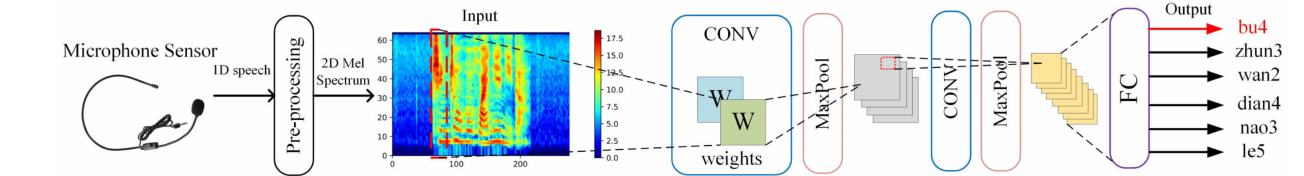
Figure 1. A typical Chinese speech recognition convolutional neural network where [bu4, zhun3, wan2, dian4, nao3, le5] is a Chinese Phoneme sequence, which in English means [stop playing